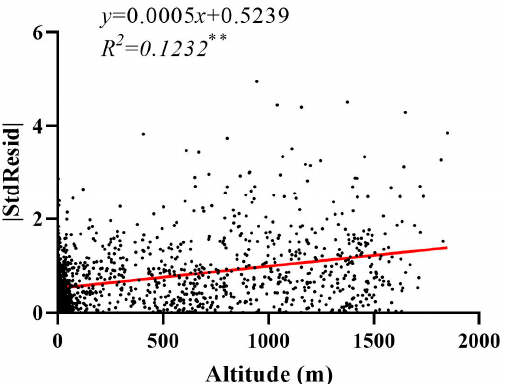
Figure 7. The fitting trend of |StdResid| (the absolute value of standard residuals by the GWR Figure 7 analysis) along with increasing altitude with the case of 12 km grid in 2015. (** p < 0.01